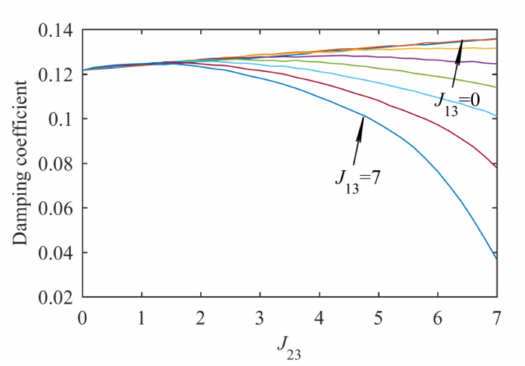
Figure 9. Relationship between factor J and the damping